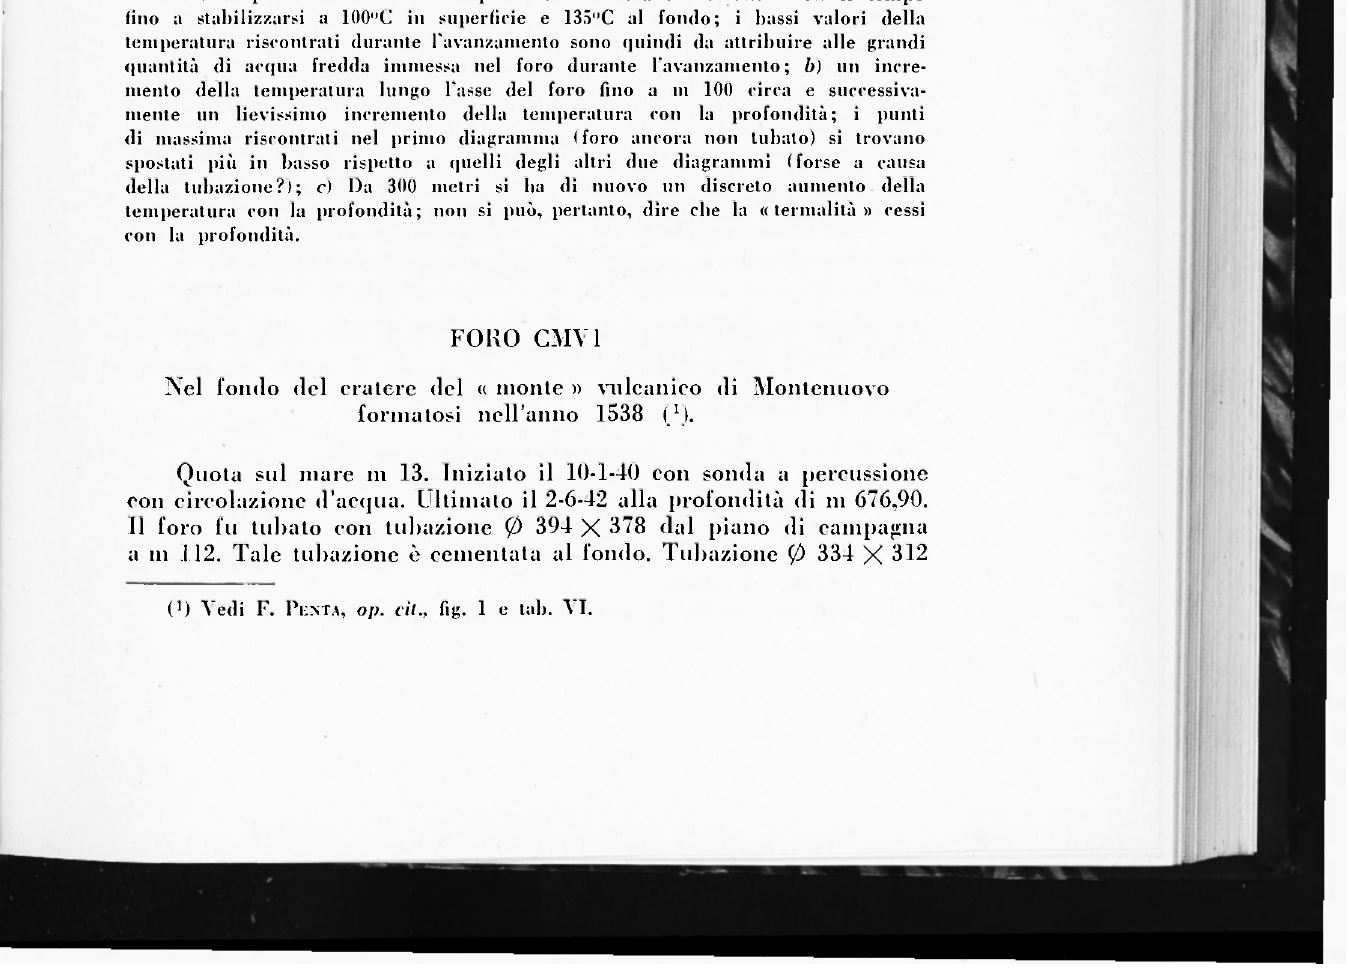
Fig. 29 - Foro CI.\ 16 profondo ni 400. Distribuzione della temperatura lungo la verticale ilei